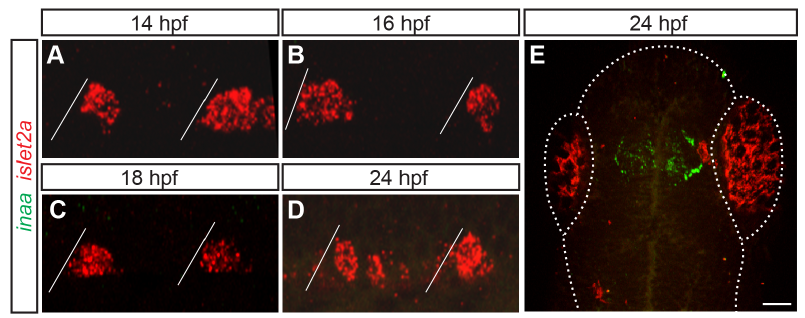
Figure 3. inaa is expressed in the zebrafish head and not in PMNs. ( A–E ) Z-projections of confocal stacks of embryos labeled with inaa and islet2a riboprobes. Diagonal lines represent somite boundaries. Between 14 hpf and 24 hpf, inaa is never coexpressed with islet2a in the trunk